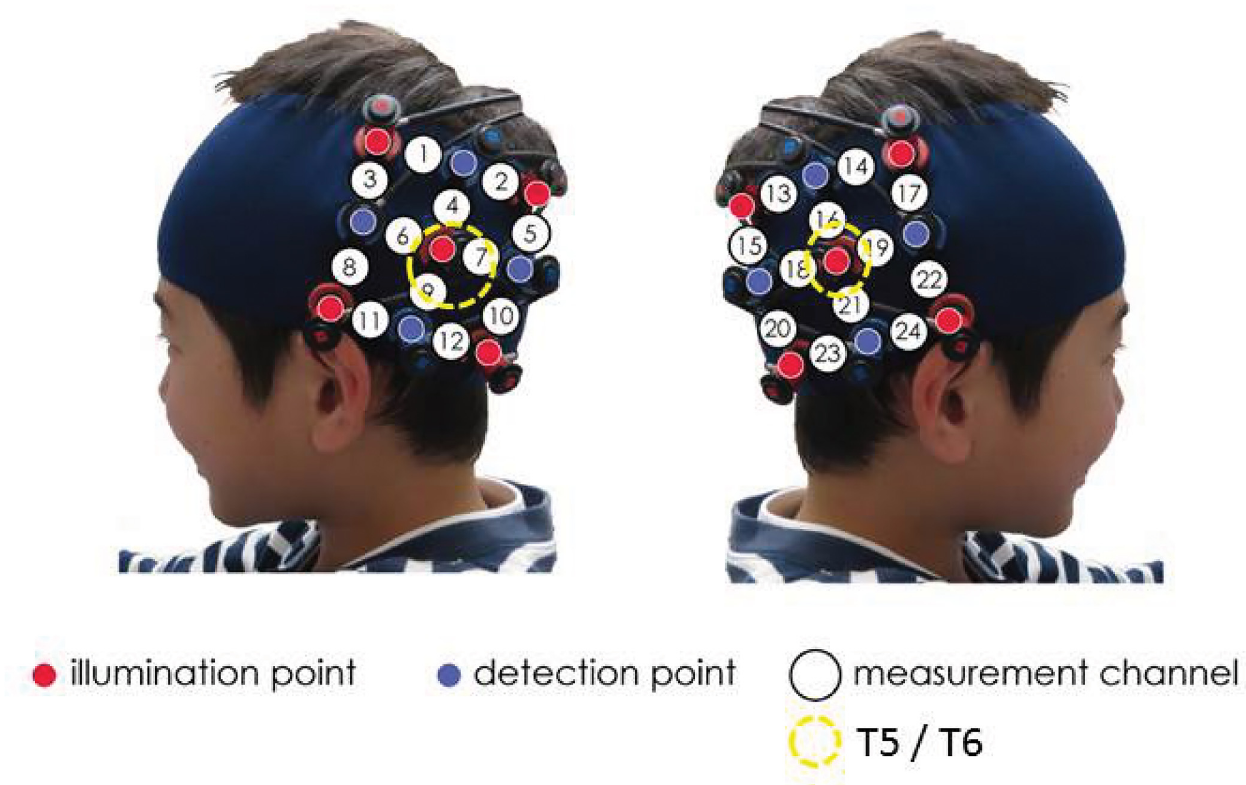
Fig 2. Placement of NIRS probes. The probes were placed on the left and right temporal areas centering at T5 and T6 of the International 10 – 20 system. T5/T6 is indicated by the yellow circle. The distance between the probes was set at 3 cm.